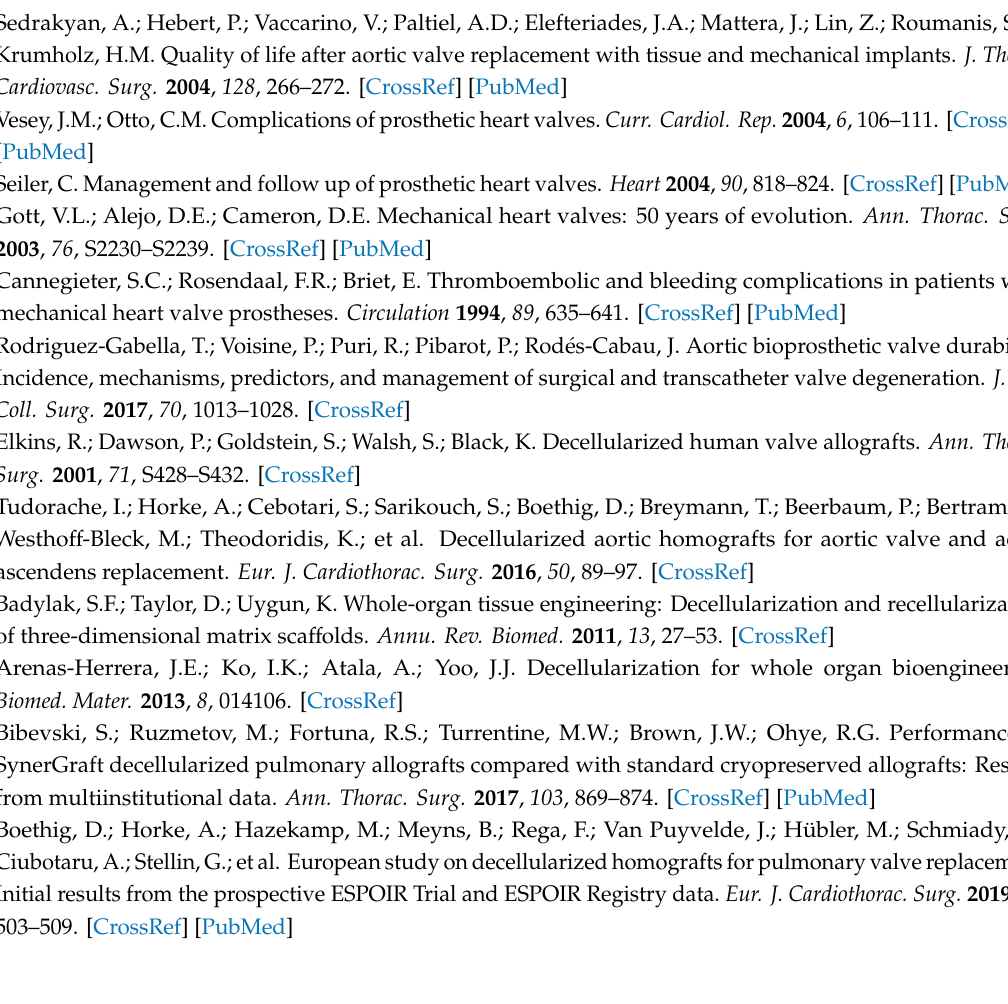
force microscopy; Figure S11. The experimental setup (1—cylinder with CO 2 , 2—pump, 3—reactor thermostat, 4—regulating valve thermostat, 5—reactor, 6—fine adjustment valve); Figure S12. Schematic representation of the sample preparation for uniaxial tensile testing; Figure S13. Characterization of the human umbilical cord multipotent mesenchymal stromal cells by flow cytometry. The cells (passage 4) were stained for the specific surface markers as described in Materials and Methods section. Expanded cells demonstrated the expression of CD44, CD105, CD90, CD73 and were negative for CD45, CD34, CD11b, CD19 and HLA-DR (green). Isotype controls conjugated with PE (blue) was run for the